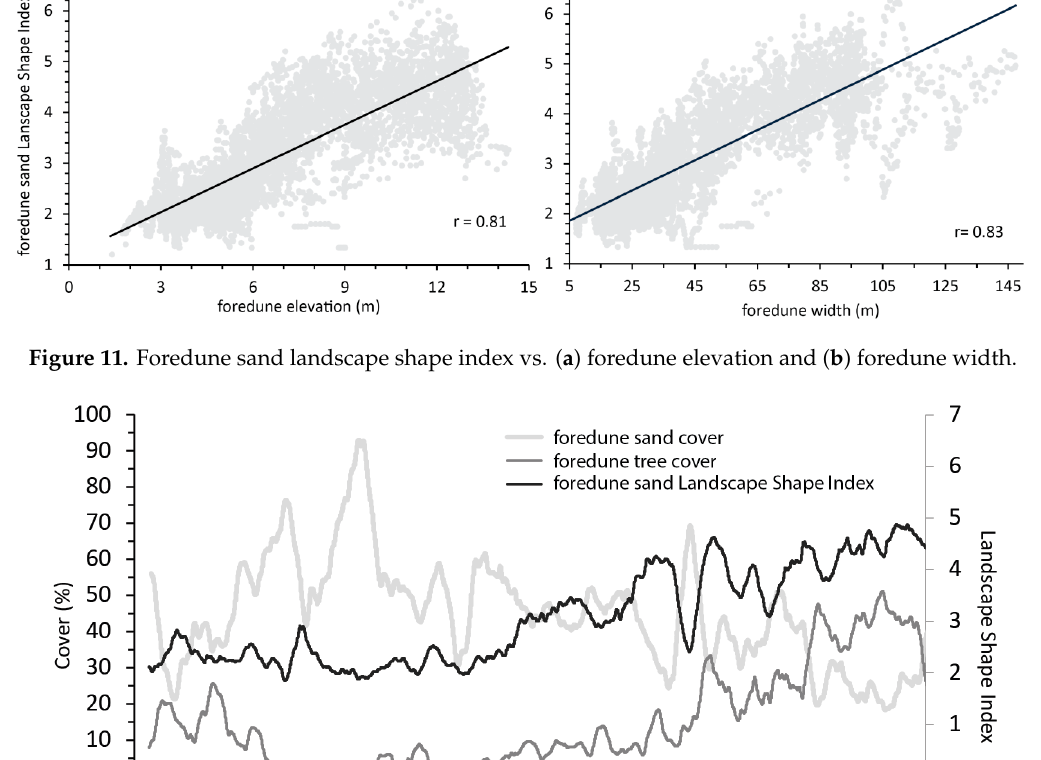
Figure 11. Foredune sand landscape shape index vs. ( a ) foredune elevation and ( b ) foredune width.